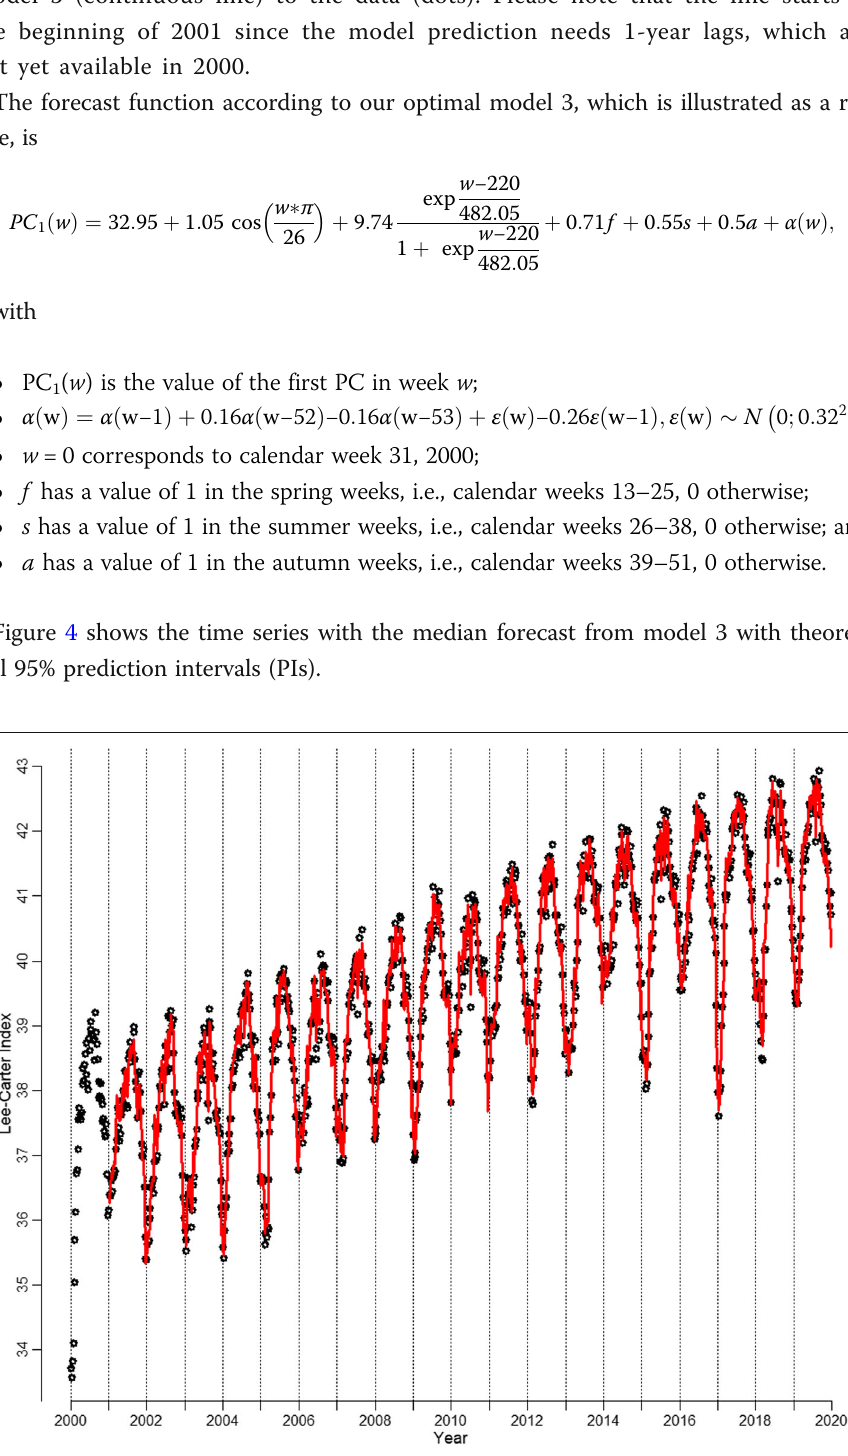
Fig. 3 Course of the Lee-Carter Index for 2000 – 2019 with model